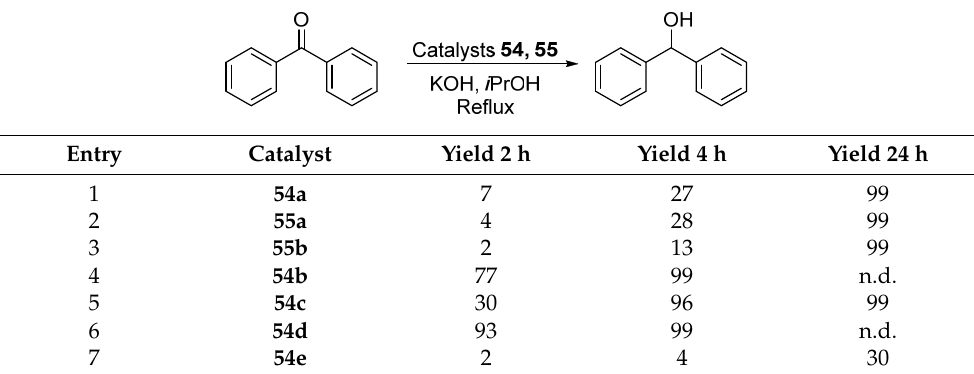
Table 1. Rate comparison of iridacycles 54a – e and 55a,b in the TH of benzophenone.